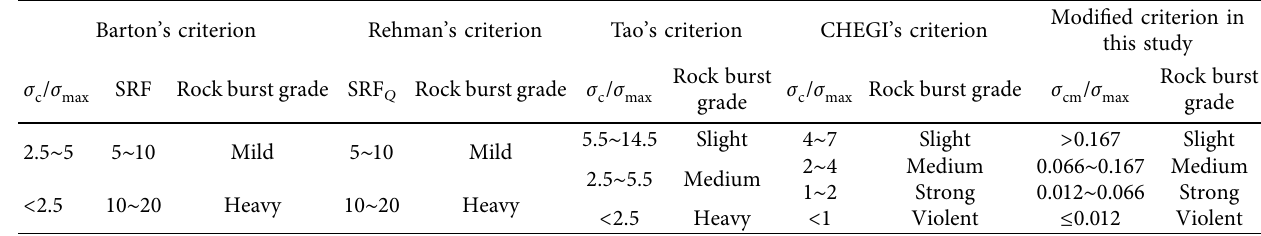
Table 14: Various criteria for rock burst estimation ∗ .